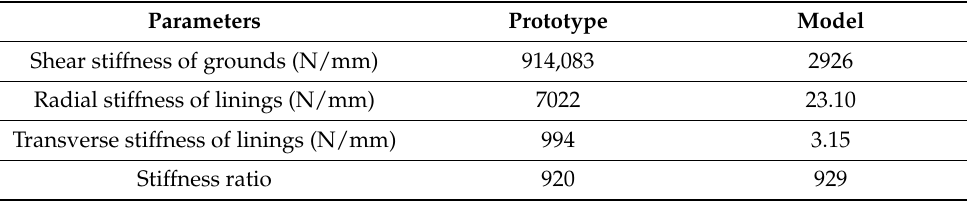
Table 3. Parameters of soil and structure of prototype and model.